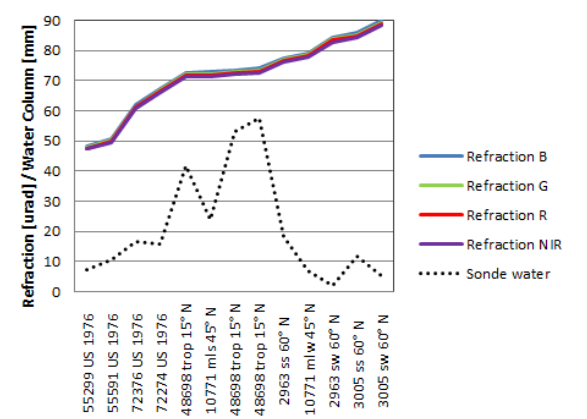
Figure 3. Refraction for different spectral colors at 10 km camera height vs. water column.